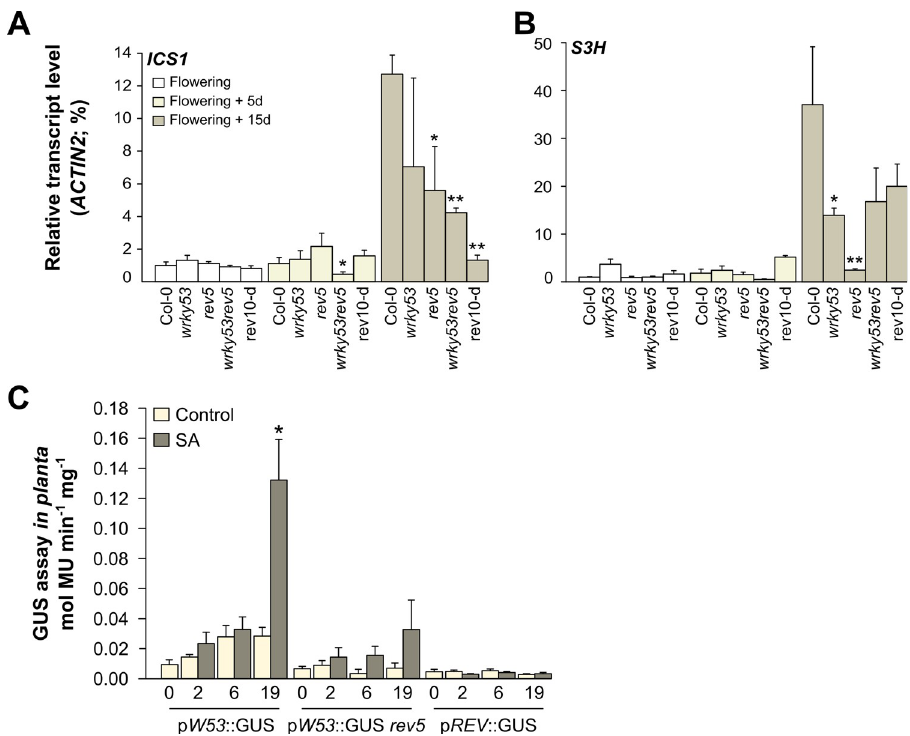
Fig 3. Genetic regulation of SA-related genes and promoter activities of REV and WRKY53 after salicylic acid treatments. Gene expression analysis by qRT-PCR over development: ( A ) ICS1 and ( B ) S3H . qRT-PCR was performed in leaf at position 10, pooled by 5 per genotype per stage. Transcriptional levels were calculated based on the comparative ΔΔ C T method and normalized to ACTIN2 levels. Data are means ( ± SE) of 2 biological replicates with 1–2 technical replicates. ( C ) Dynamics of GUS activities in planta after SA treatment. p WRKY53 ::GUS lines in Col-0 and rev5 background, and p REV ::GUS plants in rev9 knock-out mutant [24, 33],were used to quantify promoter activities 2, 6 and 19 hours after treatment. Data are means ( ± SE) of 2 biological and 2 technical replicates: 6–13 plants per genotype per condition. Significant differences were analysed using Kruskal–Wallis tests ( � : P � 0.05; �� : P � 0.01). Primers used for qRT-PCR are listed in S4 Table.